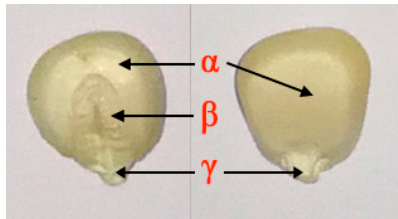
Figure 1. The structure of waxy maize seeds. The left shows the embryo side, and the right shows the non-embryo side, where ( α ) Endosperm, ( β ) Embryo, ( γ ) Tip cap (fruit stalk).